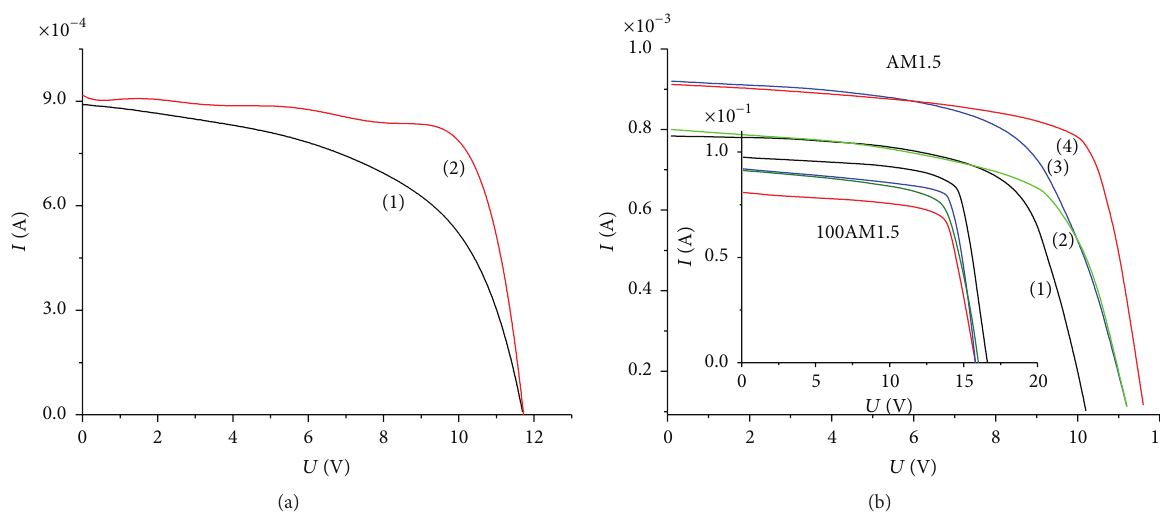
Figure 4: 𝐼 - 𝑈 characteristics of MJ Si-SC under light illumination: (a) (1)—initial curve, (2)—with DLC coating (compensated technique); (b) 𝐼 - 𝑈 curves obtained by loaded technique with respect to the treatments: (1)—initial; (2)—after H + plasma etching for 5 min; (3)—(2) + Ar + + H + ; and (4)—(3) + DLCF sputtering. Inset: 𝐼 - 𝑈 curves (treatment is (4)) obtained by pulsed flash light assisted loaded technique. Conditions of illumination: 𝑃 = 100 mW/ c m 2 ( 0V 1.5) and pulse 𝑃 = 10000 mW/ c m 2 (100 0V 1.5), 𝑆 = 6 cm 2 .